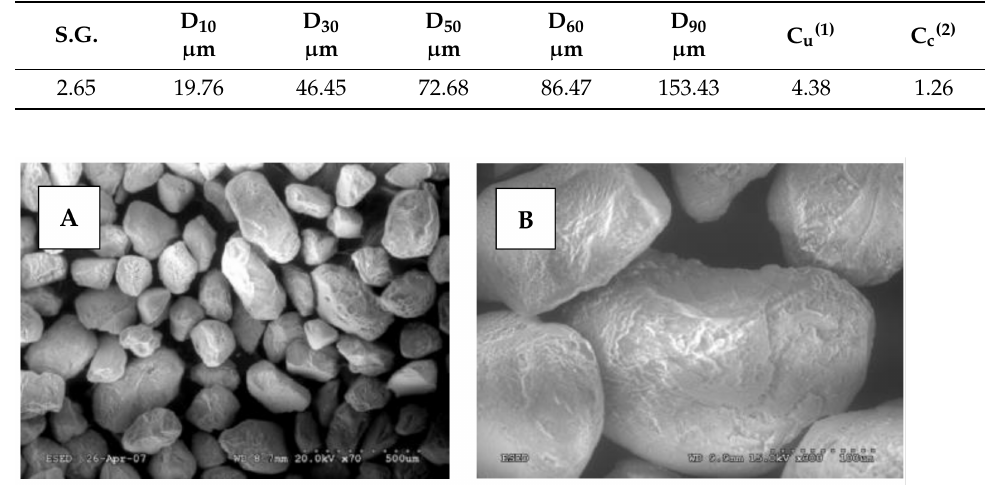
Figure 1. Grain size distribution of the silica sand used to create backfill specimens. Table 1. Physical properties of the silica sand used to create backfill specimens.